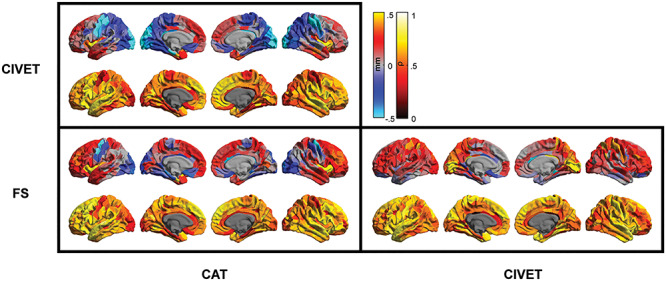
Regional between-pipeline comparison of cortical thickness estimates within the GOBS sample. Top rows: paired-difference map of cortical thickness estimates; red-yellow colors depict higher thickness estimate of the pipeline mentioned in column versus row and the dark-light blue depicts the opposite direction. Only regions with significant paired t-test comparisons are colored (P < 4 × 10−5); lower rows: between-pipeline regional Spearman’s correlation.